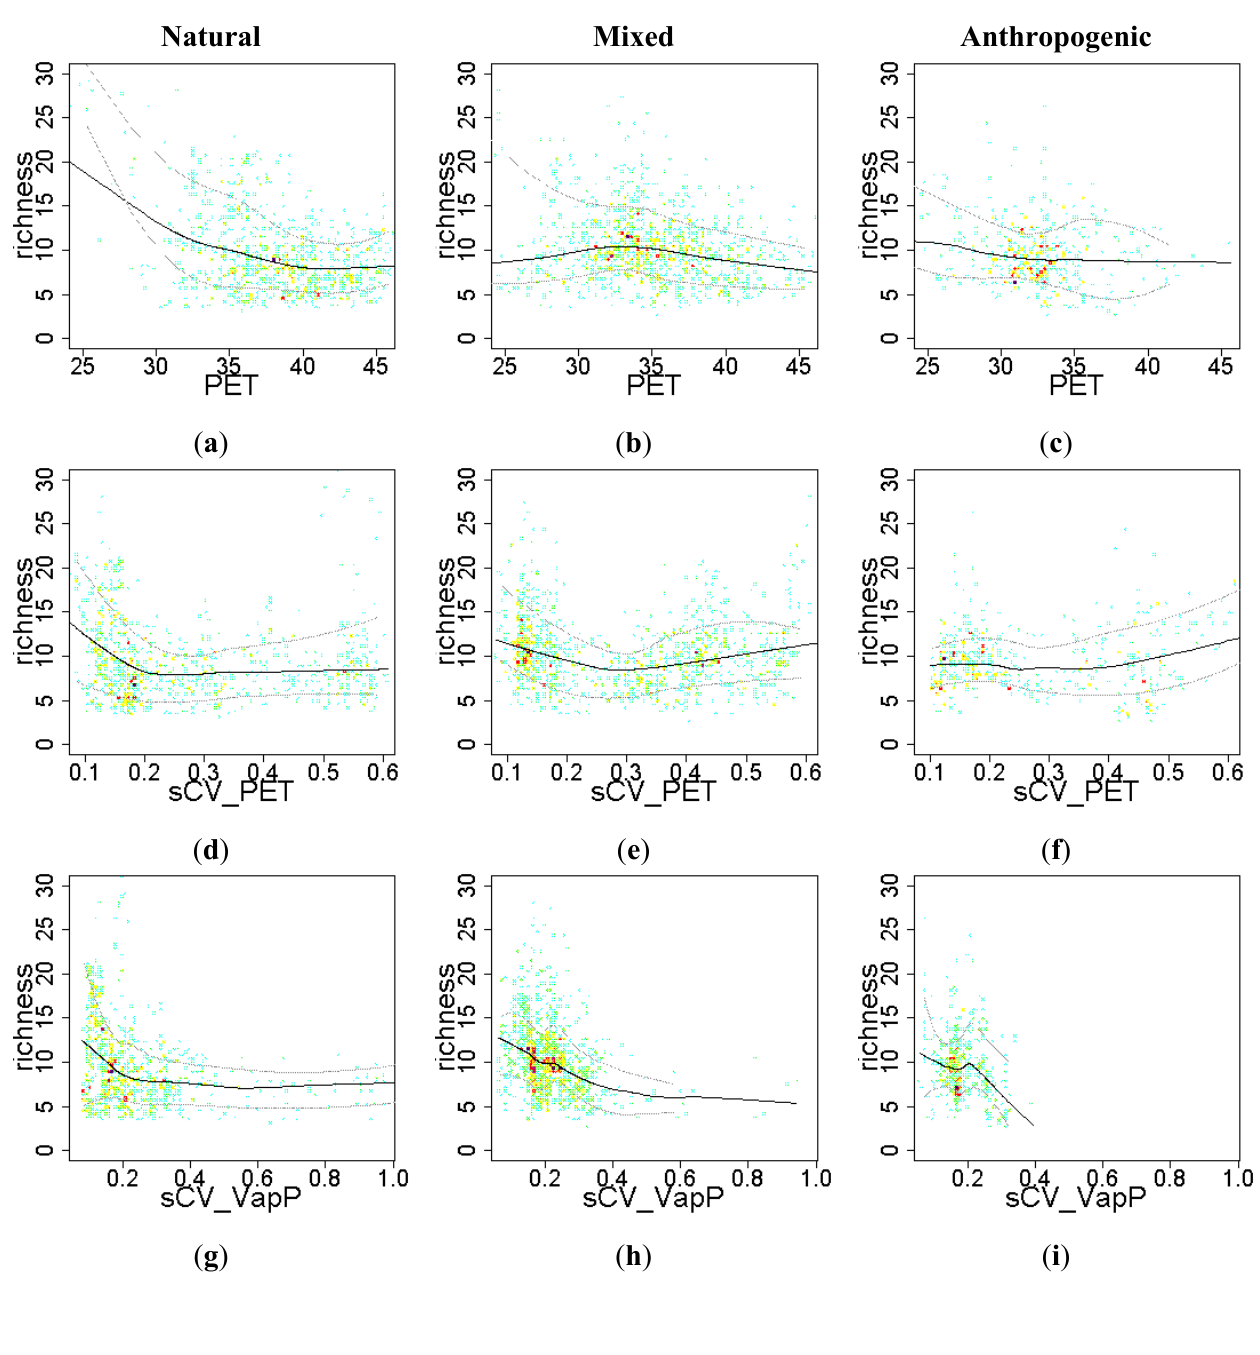
Figure 6. Relationship between the EFT richness and “energy - water availability” variables. To visualize the sense of the effect, we used warmer colors for high point density and Local Polynomial Regression Fitting (LOESS) on the 10th, 50th and 90th percentile. Relationships were compared across a Human Influence Index (HII) gradient: natural ecosystems (HII < 10), mixed (10 < HII < 20) and anthropogenic systems (HII > 20). PET: potential evapotranspiration; sCV_PET: seasonal coefficient of variation of potential evapotranspiration; sCV_VapP: seasonal coefficient of variation of vapor